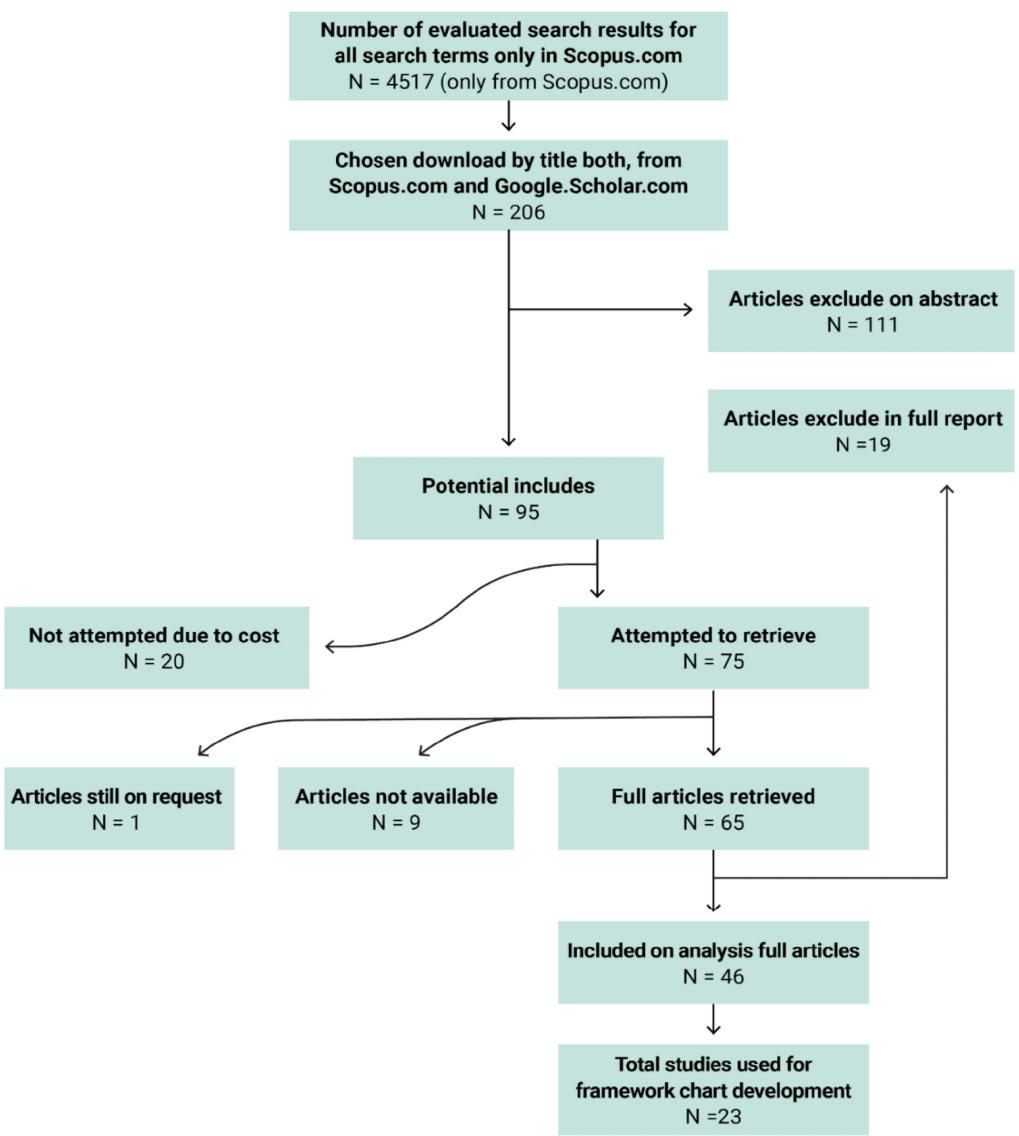
Figure 7. A synthesis of research addressing land uplift, sea-level rise and their relationship. Chart showing the flow of the literature search and evaluation procedure. N = number of articles and books used for synthesis [74].